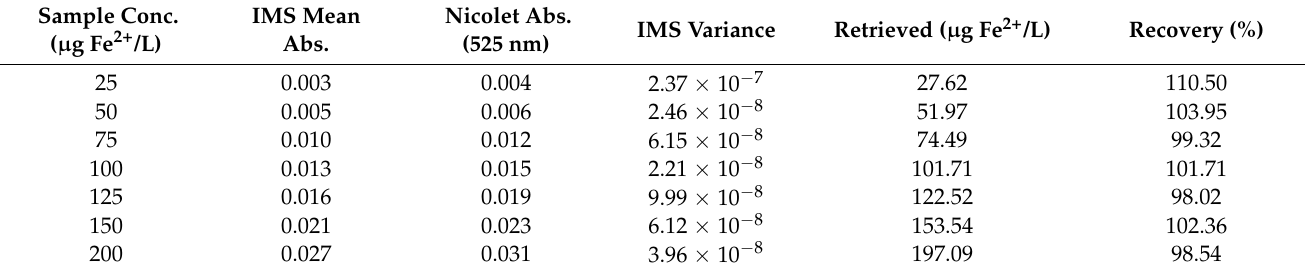
Table 5. Measurements of absorbance in second series of iron standard samples.